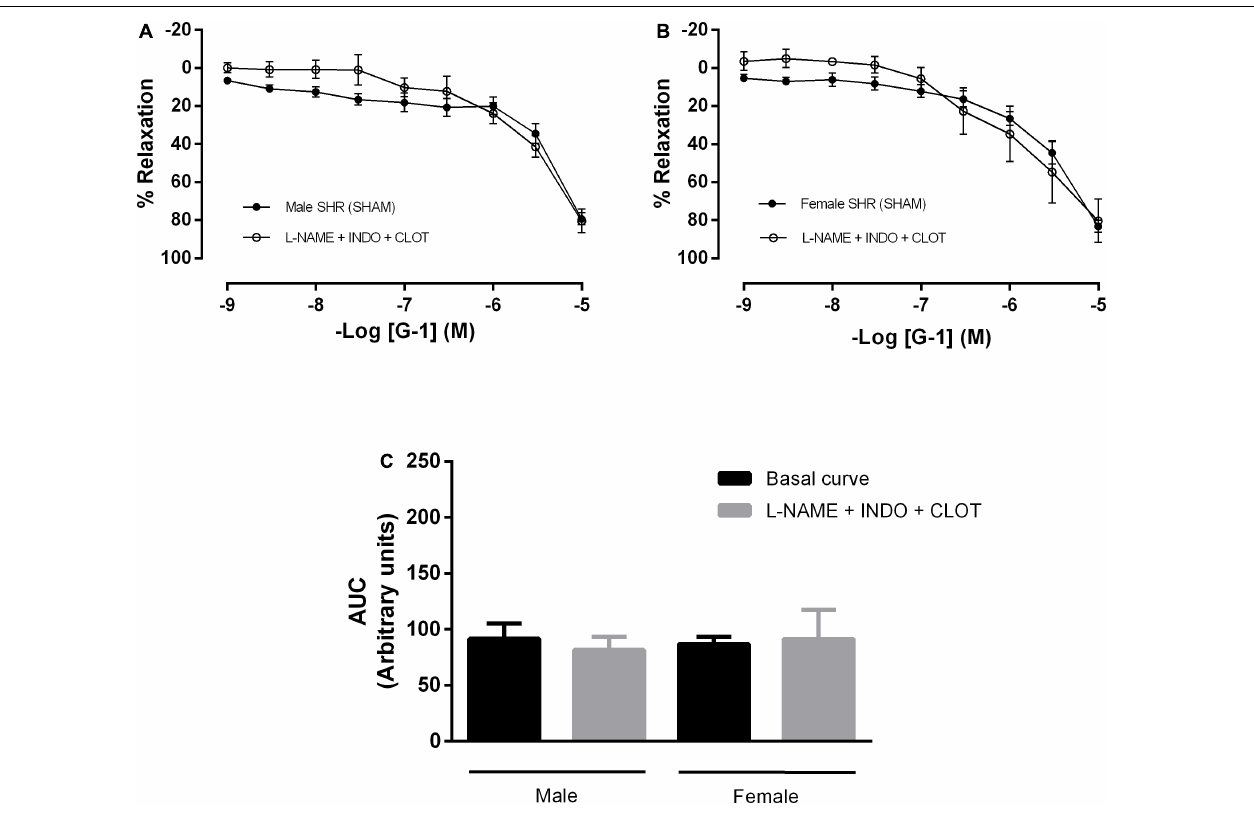
FIGURE 6 | The cytochrome P450 (CYP) pathway, one of the pathways of endothelium-dependent hyperpolarization, does not participate in the vasodilator response induced by G-1 in either sex. Effect of non-selective nitric oxide synthase inhibition with N ω -nitro-L-arginine methyl ester (L-NAME, 300 µ M), cyclooxygenase inhibition with indomethacin (INDO, 10 µ M) and cytochrome P450 (CYP) inhibition (Clotrimazole, 0.75 µ M) in (A) Male ( n = 5) and (B) Female ( n = 5) SHR groups. (C) Area under the curve (AUC) before and after L-NAME, INDO, and Clotrimazole incubation. Values are expressed as mean ± SEM. The curve analysis was carried out point-by-point through two-way ANOVA, followed by the Sidak post hoc test. AUCs were evaluated through one-way ANOVA followed by Tukey post hoc test.